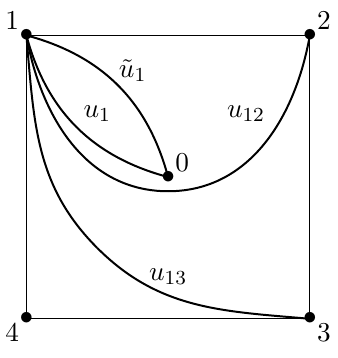
Figure 1 . A representative example showing the conventions for labelling u